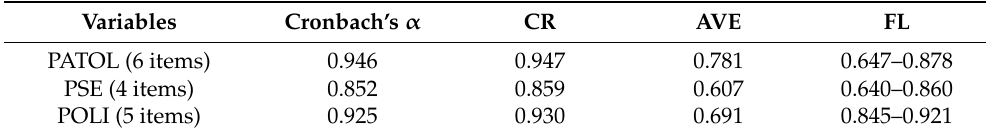
Table 1. Reliability and Validity